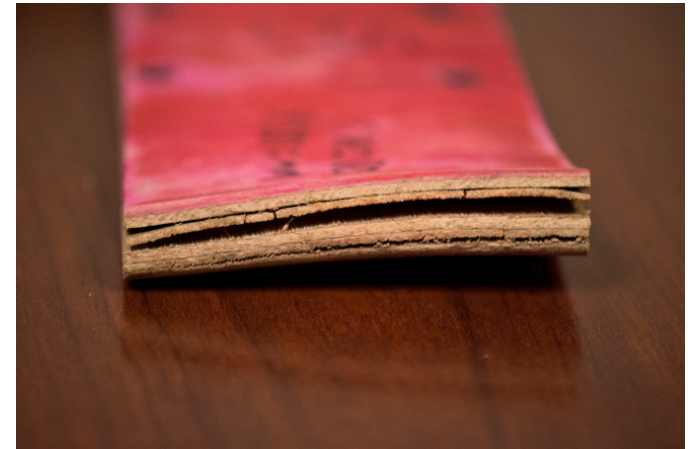
Figure 15. Face wise wide view of sample 2 showing delamination after soak/dry moisture durability test (ANSI/HVPA EF 2009 [4]).